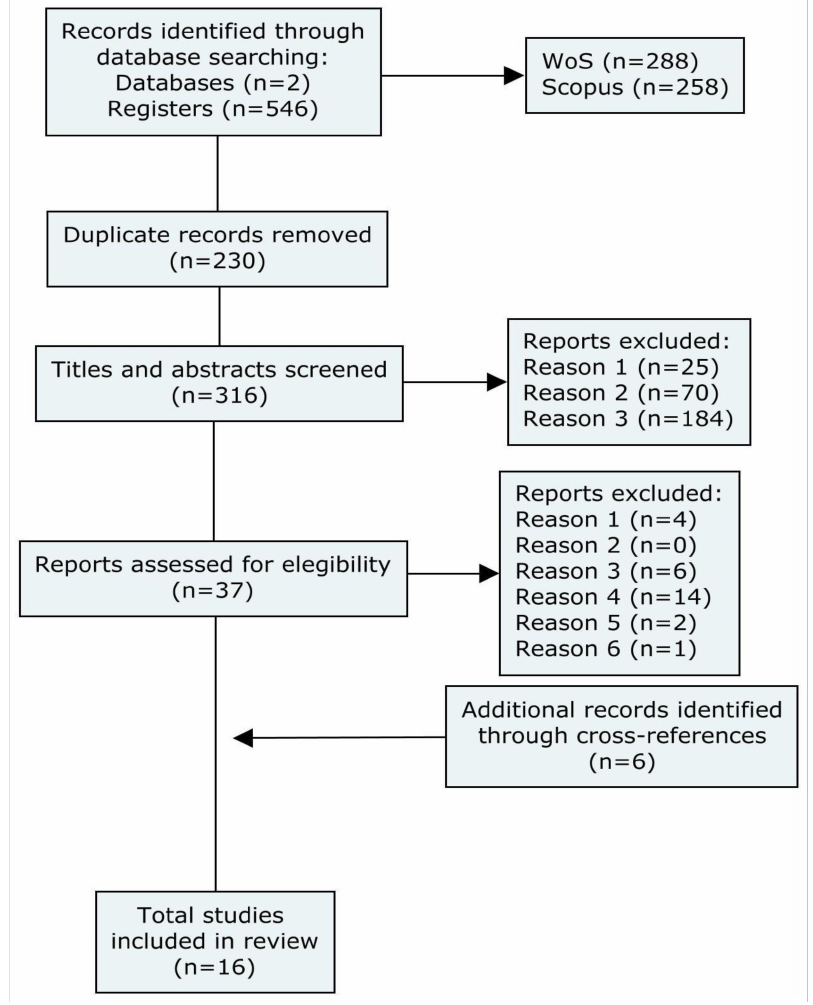
Figure 1. Scoping review search